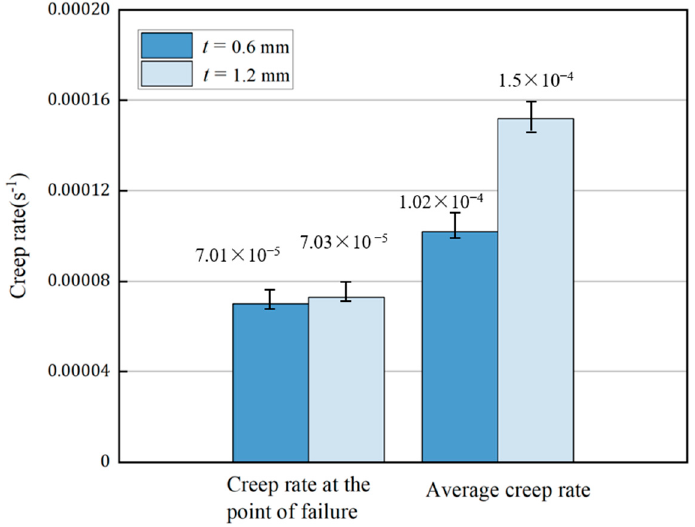
Figure 11. Comparison of the creep rate at the rupture point and the average creep rate during the second creep stage of the specimens of two